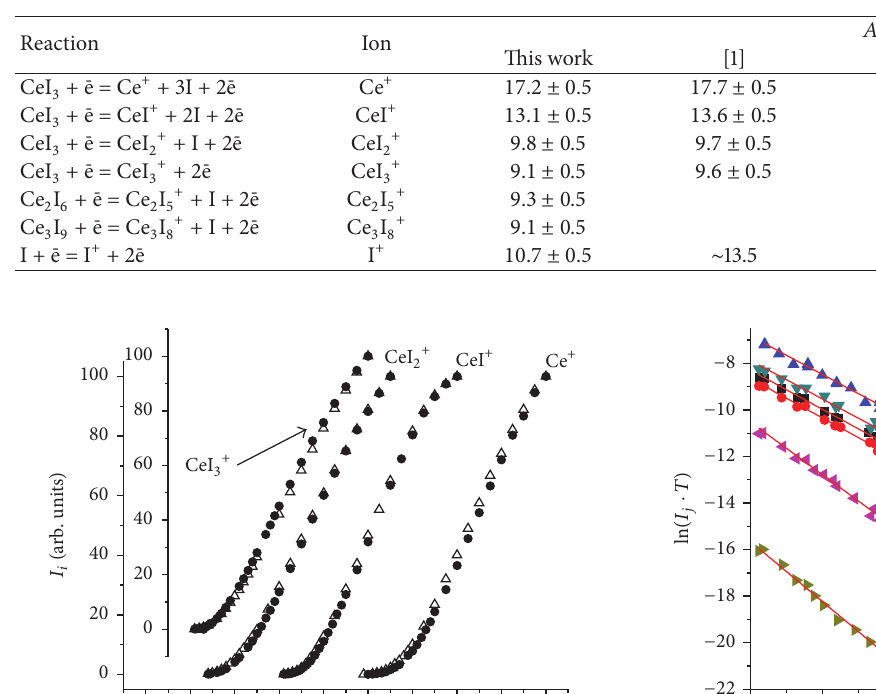
Table 1: Ion appearance energies (eV).